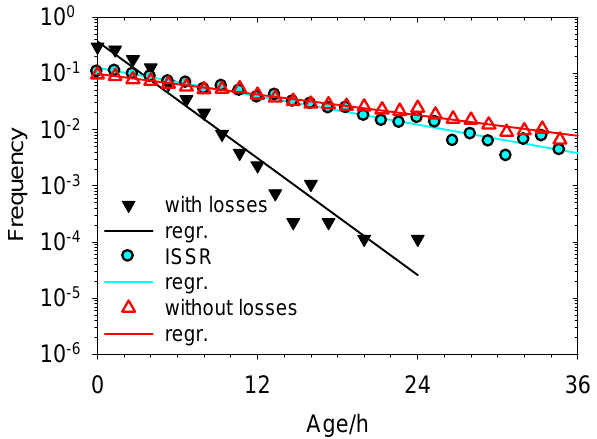
Fig. 9. Age frequency of ice supersaturated regions (cyan: ISSR) and of contrails (black: with losses, red: without losses) in a set of contrail segments as in Fig.